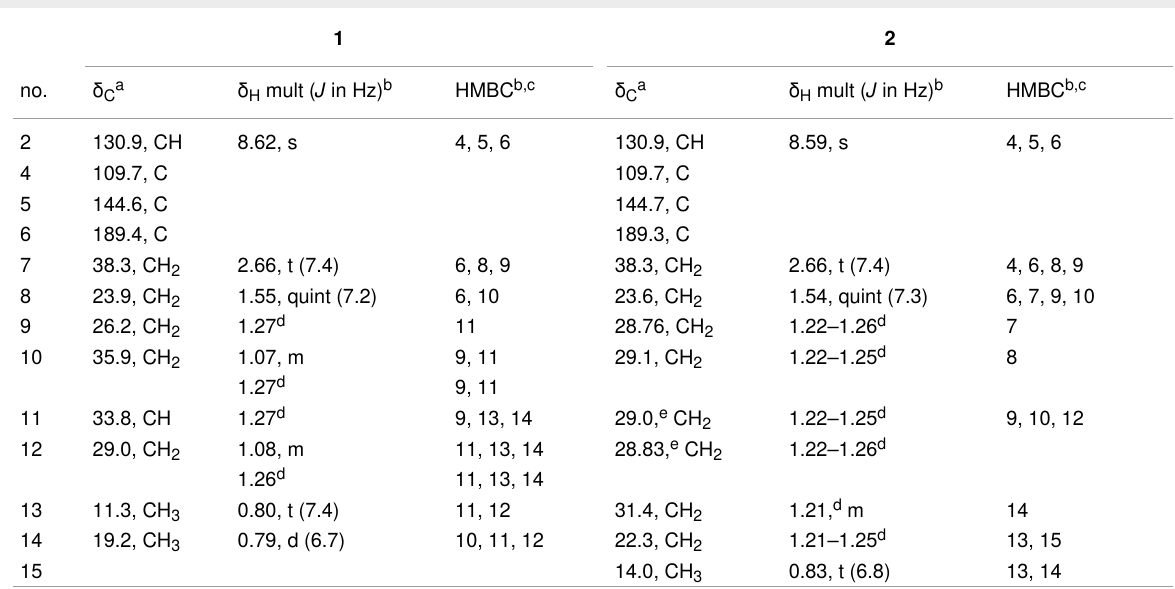
Table 1: 1 H and 13 C NMR spectroscopic data for nocarimidazoles C ( 1 ) and D ( 2 ) in DMSO- d 6 with TFA.